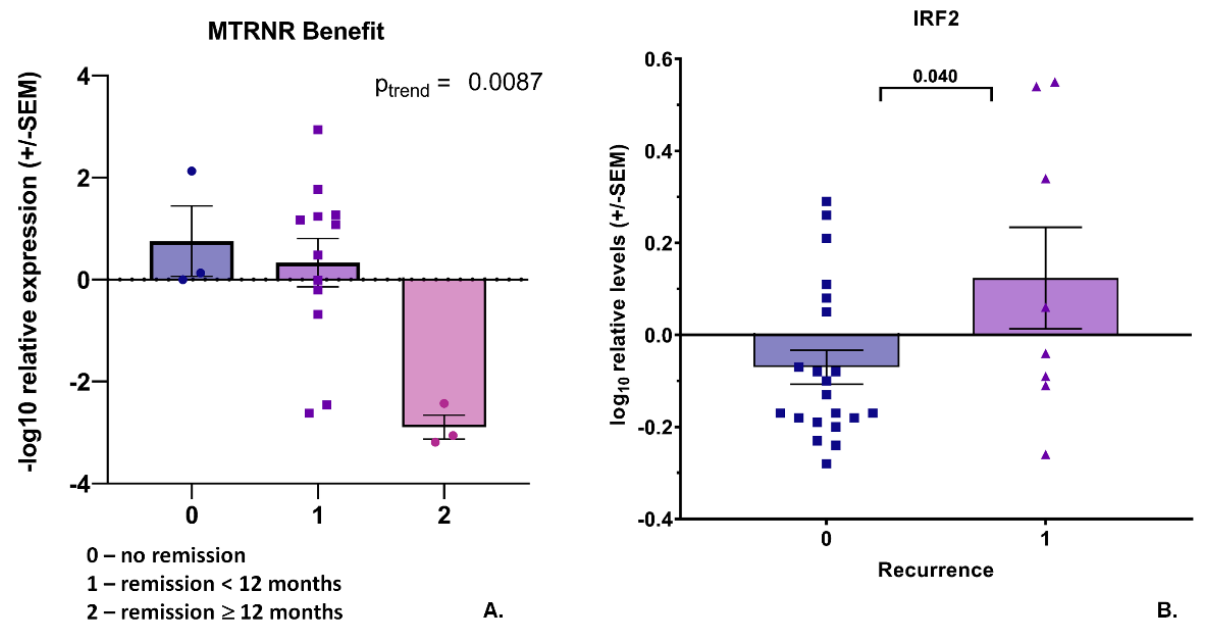
Figure 6. Associations between transcripts’ expression in blood-derived mRNA and treatment response or disease recurrence in ADT − cohort. ( A ) Bar graph showing − log10 relative expression levels of MT-RNR1 in different benefit groups as specified in the key. p value indicated after linear test for trend following ANOVA. ( B ) Log10 relative expression levels of IRF2 in groups with different disease recurrences. p value indicated after unpaired t -test between two